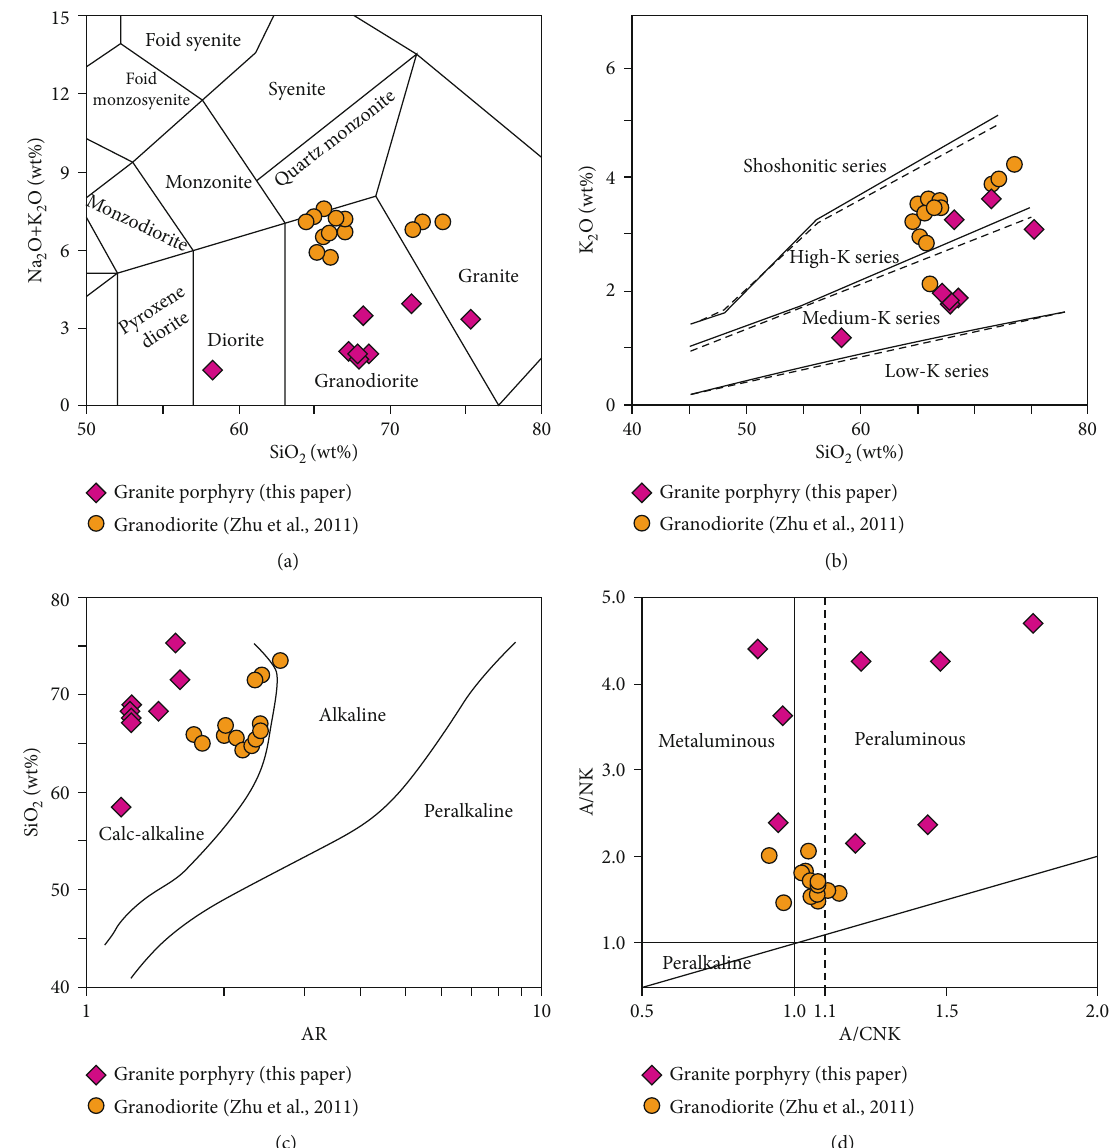
Figure 12: Major element diagrams of the granite porphyries and granodiorite in Yangla copper deposit, Yunnan, China. (a) TAS diagrams after Middlemost, 1994 [73]. (b) SiO -K O diagrams after Morrison, 1980, Rickwood, 1989, and Rollinson, 1993 [74 – 76]. (c) SiO 2 2 diagrams after Wright, 1969 [77]. (d) A/NK-A/CNK diagrams after Maniar and Piccoli, 1989